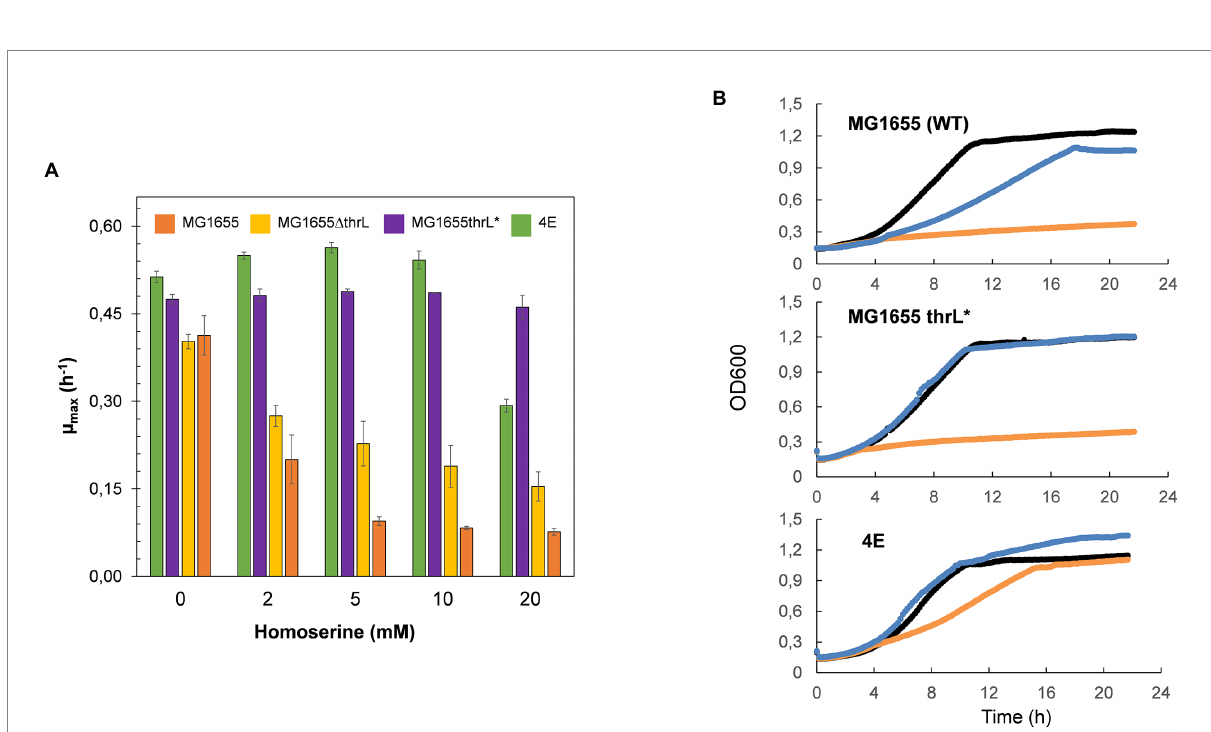
FIGURE 3 Replacement of thrL by thrL* in wild type MG1655 alleviated L-homoserine toxicity but does not allow growth with this amino acid as sole nitrogen source. In (A) effect of L-homoserine on maximal growth rate ( μ ) of MG1655, MG1655 Δ thrL MG1655 thrL * and 4E strain. In (B) growth of MG1655, MG1655 Δ thrL ), MG1655 thrL * and 4E on M9 with NH4 + (black line), with NH4 and 10 mM homoserine (blue line) or with 15 homoserine (orange line). Data are the mean of three technical